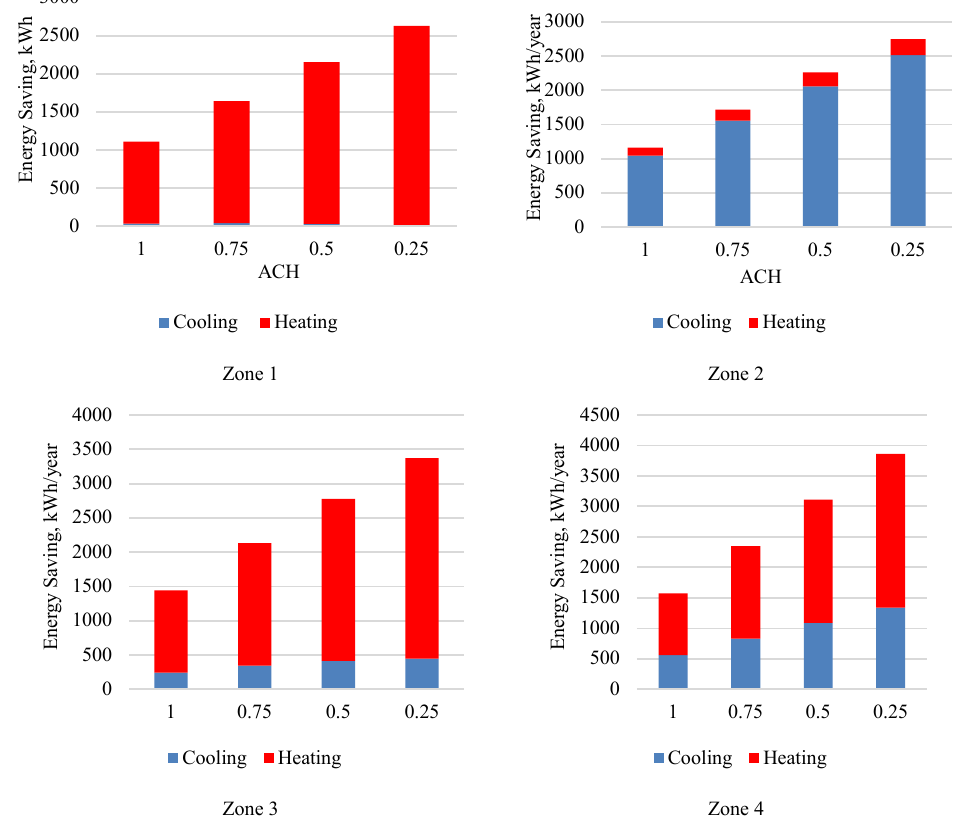
Fig. 4. Annual cooling and heating energy saving from infiltration rate reduction (ACH) in different climate